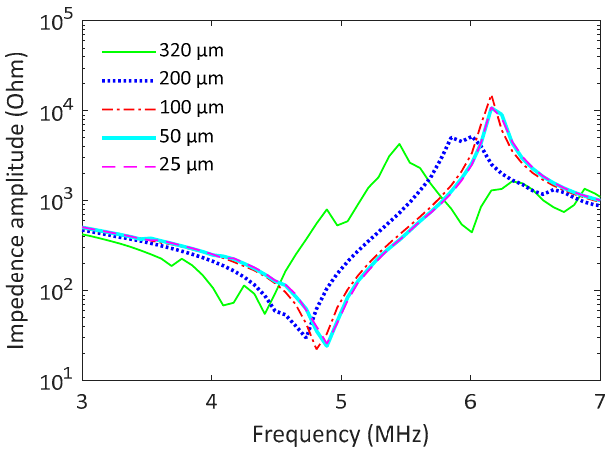
Figure 11. The amplitude of electric impedance responses with respect to the width of piezoelectric rods in the 1–3 composite transducers.